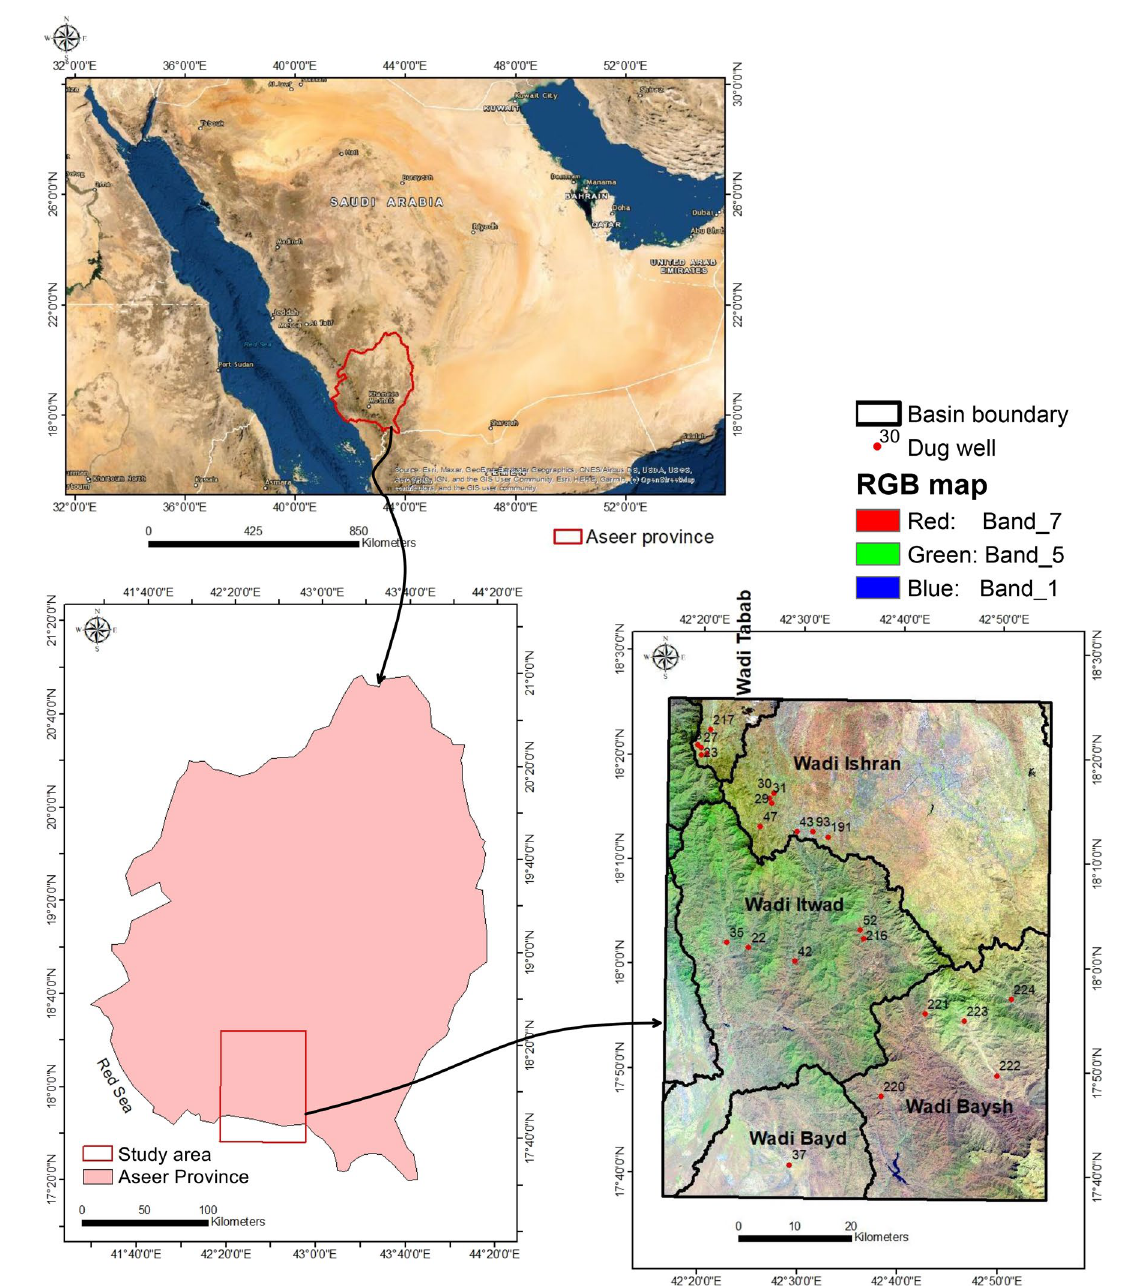
Fig. 1 Location map of the study